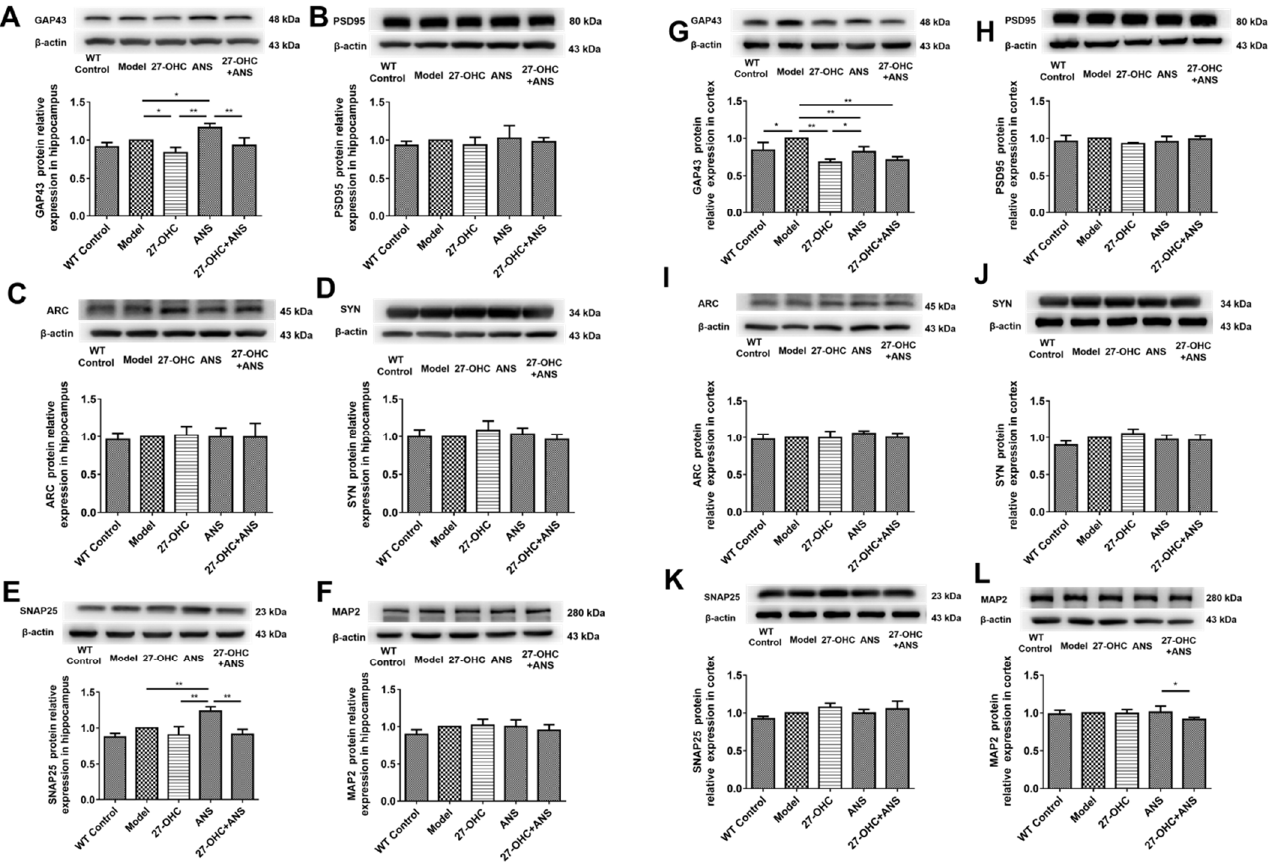
Figure 4. The protein expression of synapse-associated protein in the hippocampus and cortex: ( A ) GAP43 in the hippocampus; ( B ) PSD95 in the hippocampus; ( C ) Arc in the hippocampus; ( D ) SYN in the hippocampus; ( E ) SNAP25 in the hippocampus; ( F ) MAP2 in the hippocampus; ( G ) GAP43 in the cortex; ( H ) PSD95 in the cortex; ( I ) Arc in the cortex; ( J ) SYN in the cortex; ( K ) SNAP-25 in the cortex; ( L ) MAP2 in the cortex; Densitometric analyses were normalized to β -actin. All data are shown as mean ± SD.* p < 0.05; ** p < 0.01 (one-way ANOVA).